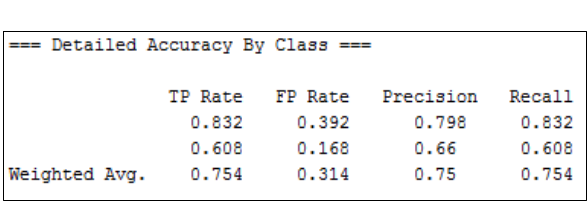
Figure 11. Diagnosis of diabetes using support vector machine.